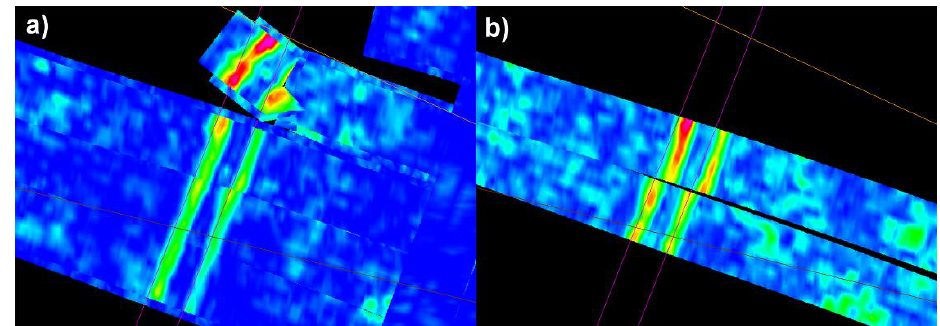
Figure 14. Results of the pass over the district heating network localised by ( a ) GPS PPS and ( b ) total station.